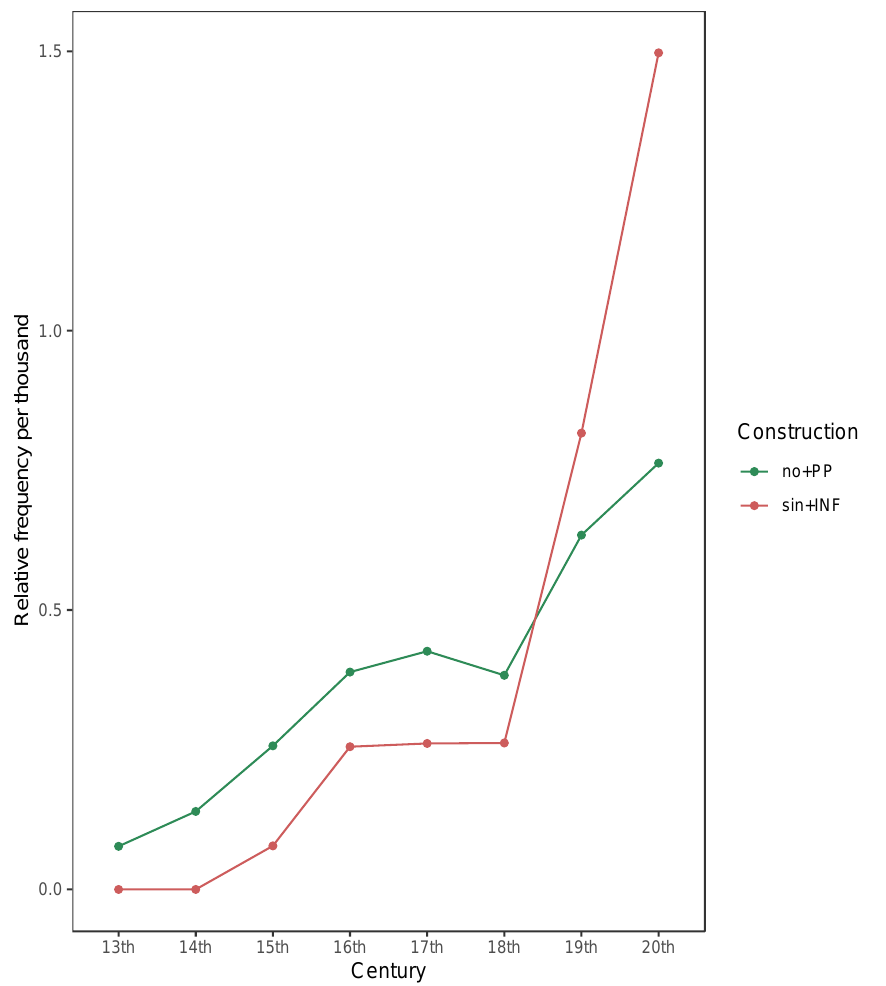
Figure 2. Relative frequency of adjectival sin + INF vs. no + PP